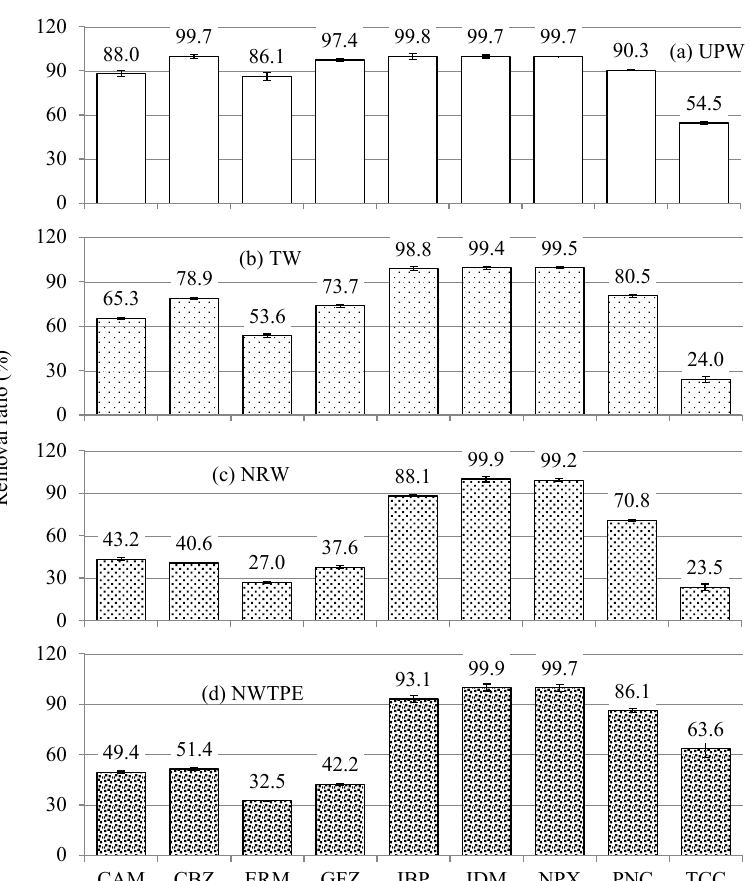
Figure 4. Removal ratios for PhCs (n = 3, 30 min reaction) by VUV photolysis in simulated mixed solutions using ultrapure water (UPW), tap water (TW), Neya River water (NRW) and Nakahama wastewater treatment plant effluent (NWTPE). Other seven PhCs with more than 99% removal ratios by UVC photolysis are not shown